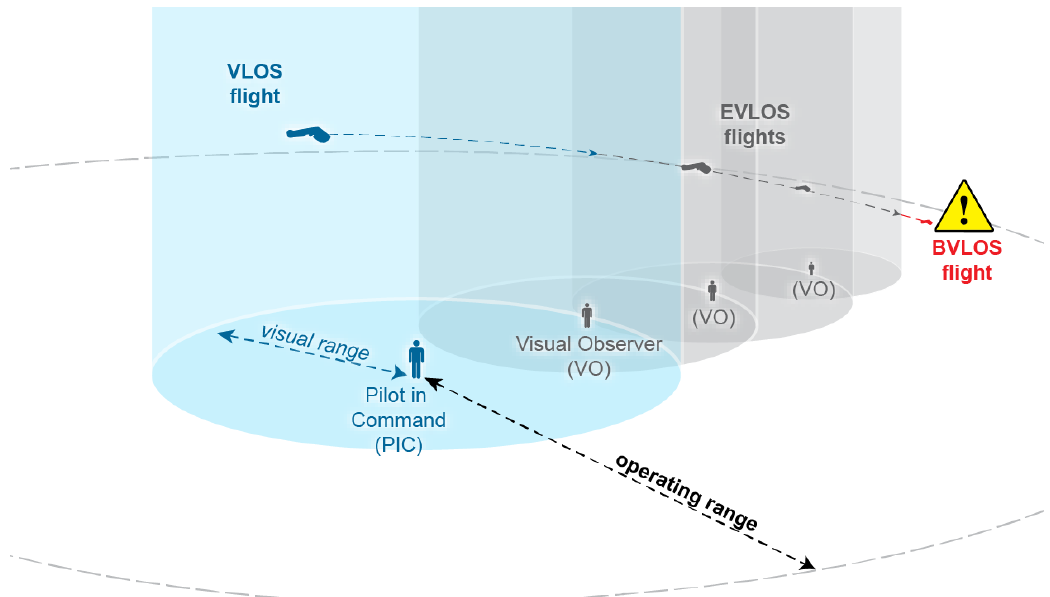
Figure 18. Flights in the visual range (VLOS), extended visual line of sight (EVLOS) and beyond visual line of sight